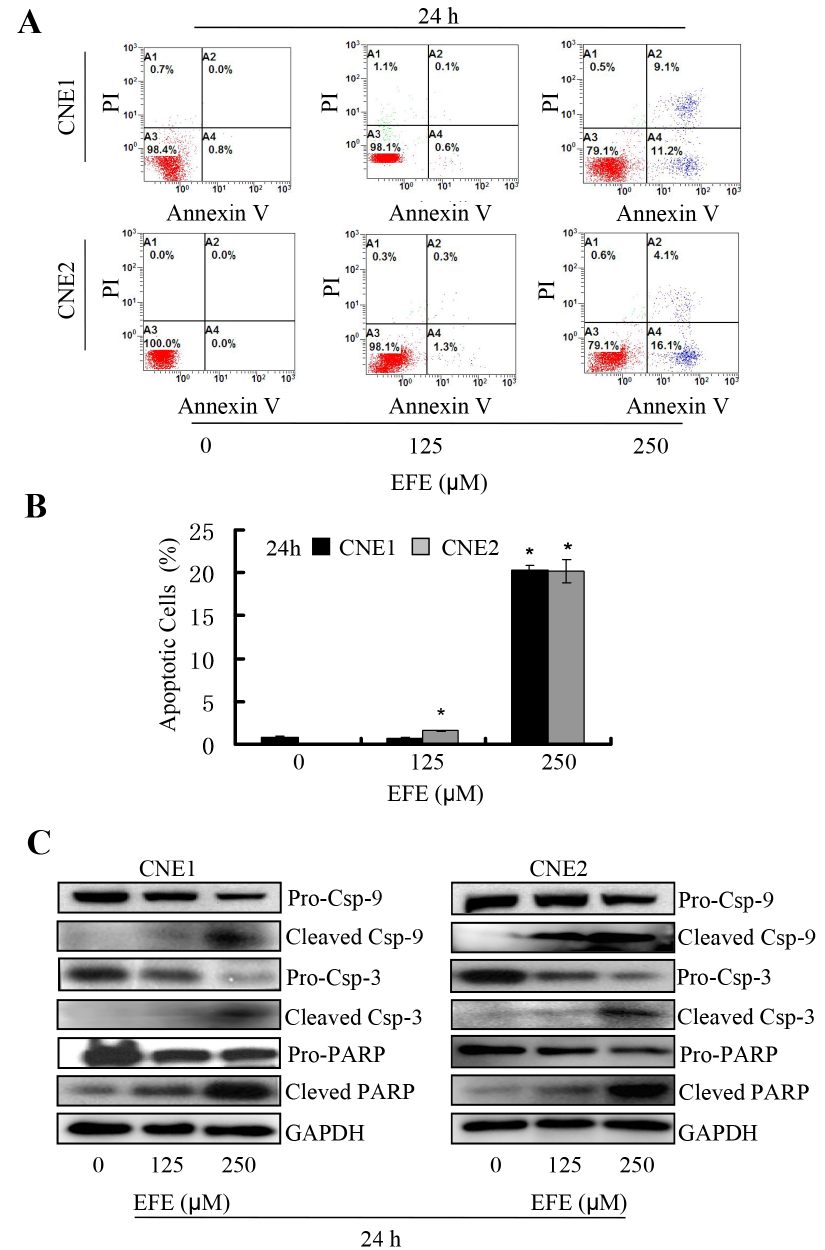
Figure 3. Effusanin E induced apoptosis. ( A ) Effusanin E (EFE) induced NPC cells apoptosis. Apoptosis was analyzed using TUNEL-based, fluorescence-activated cell sorter analysis and was represented by the relative percentages of TUNEL-positive cells versus those of DMSO-treated cells. ( B ) The percentages of apoptotic cells were calculated. ( C ) Western blotting of cleaved caspase-3, caspase-9 and PARP proteins in NPC cells. Total proteins isolated from the indicated cells were blotted with antibodies as labeled, and GAPDH was used as a control for sample